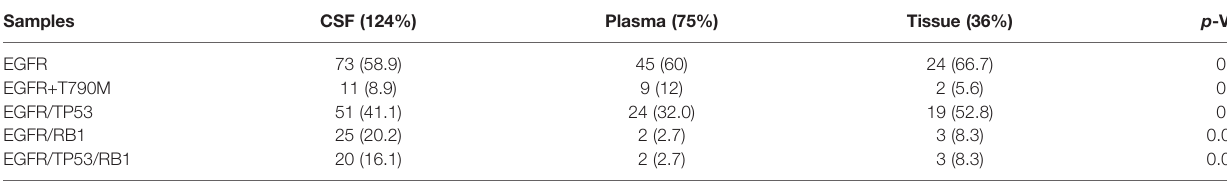
CSF, cerebrospinal fl uid.